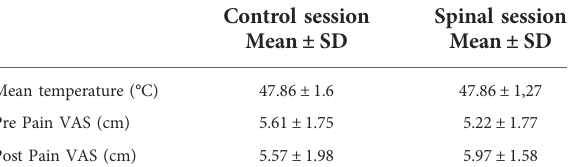
TABLE 1 Summary pain scores. Max VAS=10 cm.